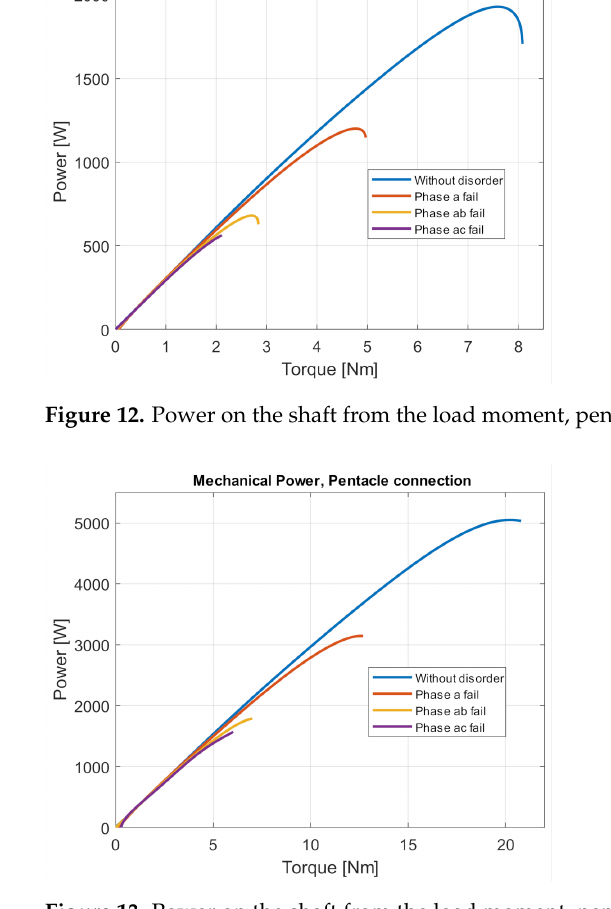
Figure 13. Power on the shaft from the load moment, pentacle connection, U IN = 5 × 230 V, 50 Hz.